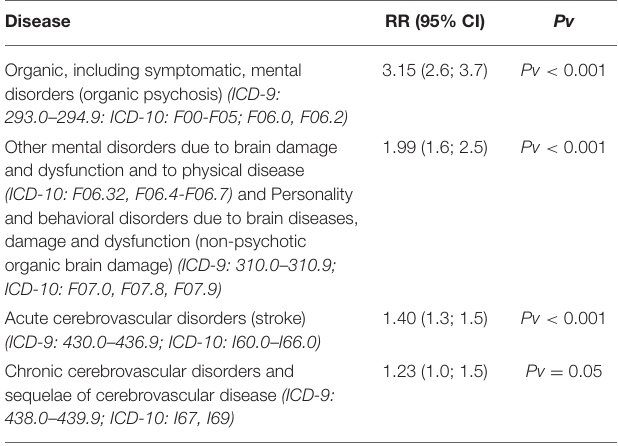
TABLE 2 | Relative risks (RR) of Incidence of neuropsychiatric disorders in clean-up workers of 1986–1987 related to internal control (doses < 50 mSv) according to the register’s